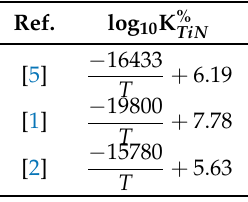
Table 1. Solubility product of TiN in pure liquid iron as a function of temperature.